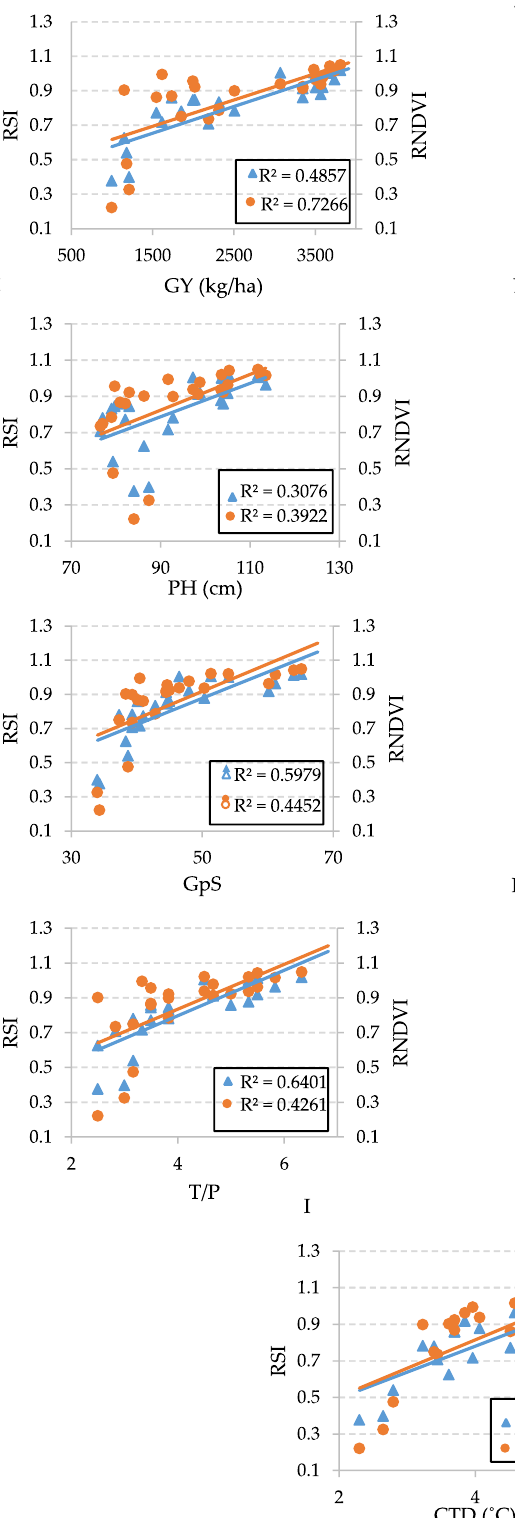
Figure 6. The relationship of RSI and RNDVI with agro-physiological traits of 12 wheat varieties grown under three N levels: ( A ) grain yield (GY), ( B ) biological yield (BY), ( C ) plant height (PH), ( D ) harvest index (HI), ( E ) grains per spike (GpS), ( F ) spike length (SL), ( G ) tiller per plant (TpP), ( H ) thousand kernel weight (TKW), ( I ) canopy temperature depression (CTD). , RSI; , RNDVI.